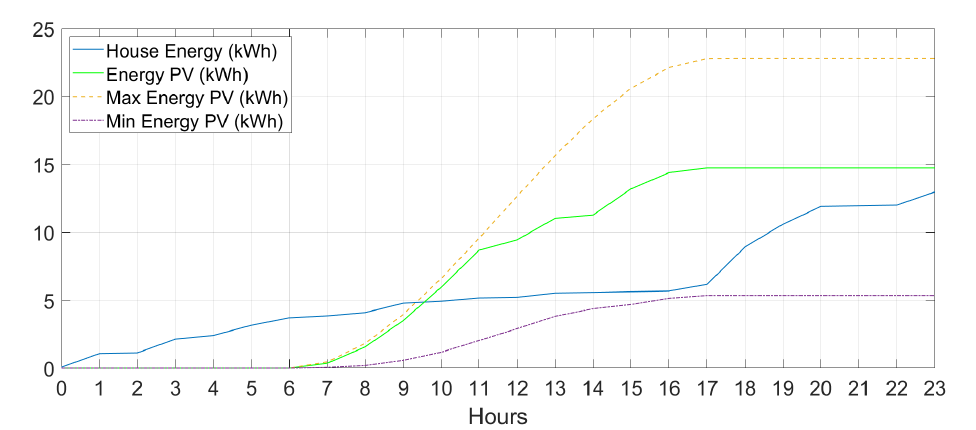
Figure 20. Profile 3 vs. 4 kW system (day).